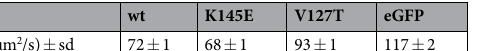
wt K145E V127T eGFP